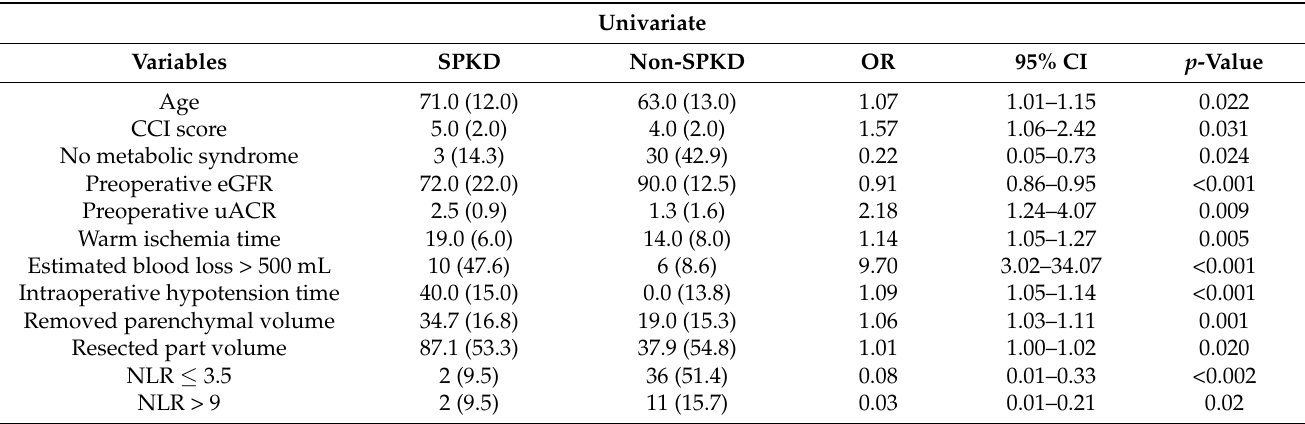
Table 3. Univariate analysis of the associations between clinical characteristics and significant postoperative kidney dysfunction persistence.